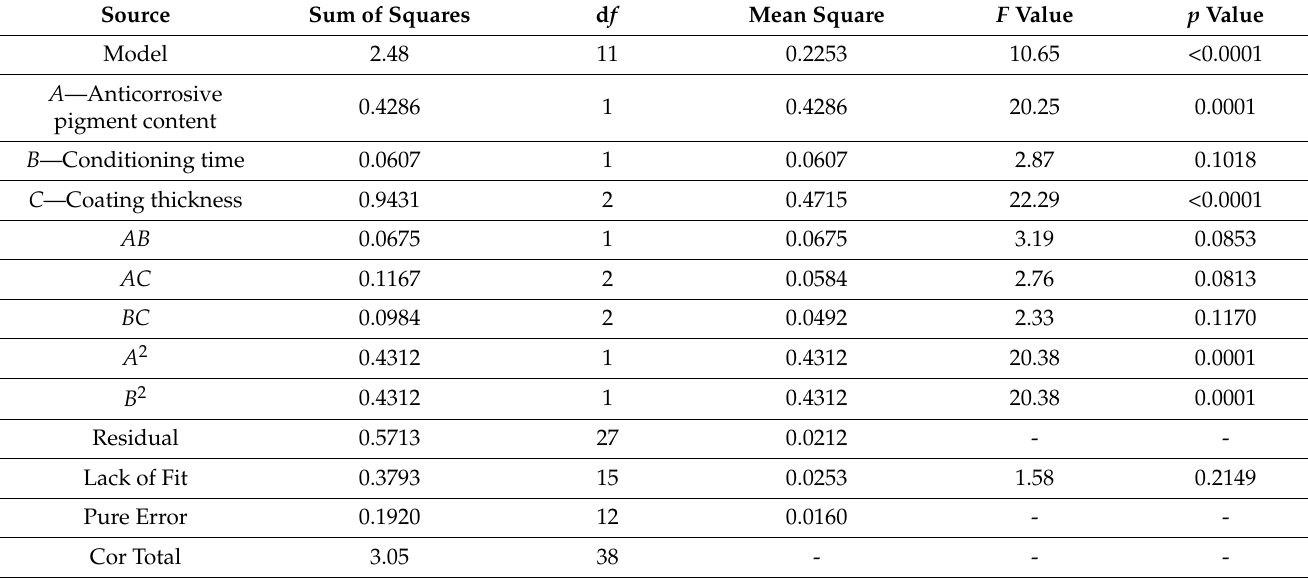
Table 5. Analysis of variance for the regression model for adhesion force between the applied coating and the substrate